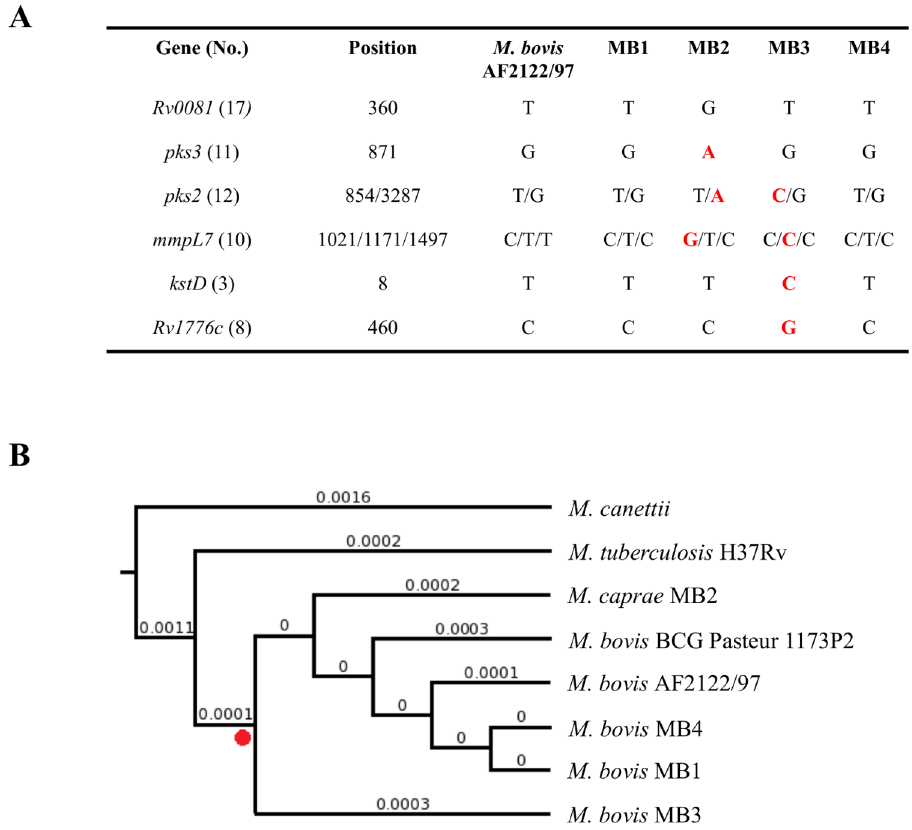
Fig 5. Genes coding for the proteins linking stress response with lipid metabolism. (A) SNPs detected in mycobacteria isolates MB1-MB4 with M . bovis AF2122/97 reference genome sequence. Non-synonymous substitutions are shown in red. Gene No. refers to row number in S3 Table. (B) Multilocus sequence analysis. The nucleotide sequences of the selected genes were concatenated and aligned to construct a maximum likelihood phylogenetic tree. Numbers of internal branches represent genetic distances. The reliability for the internal branches was assessed using the approximate likelihood ratio test (aLRT – SH-Like). The clade of M . bovis/M . caprae (red dot) is supported by an aLRT – SH-Like value of 87. M . canettii was used as outgroup. The image was built using EvolView.